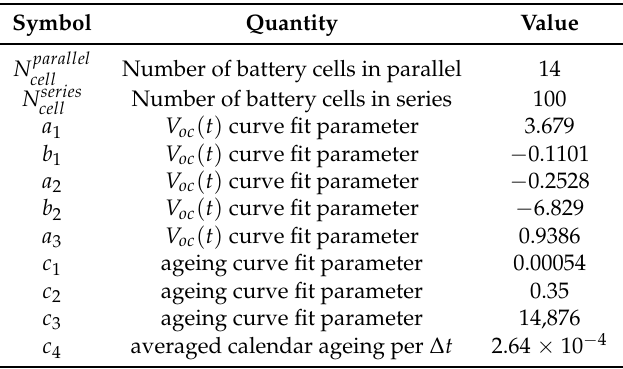
Figure 4. Open circuit voltage for a Nickel–Manganese–Cobalt (NMC) battery cell [46]: Since both the electric vehicle and the stationary battery are made of NMC technology, this cell voltage is applicable for both. Table 2. Battery model